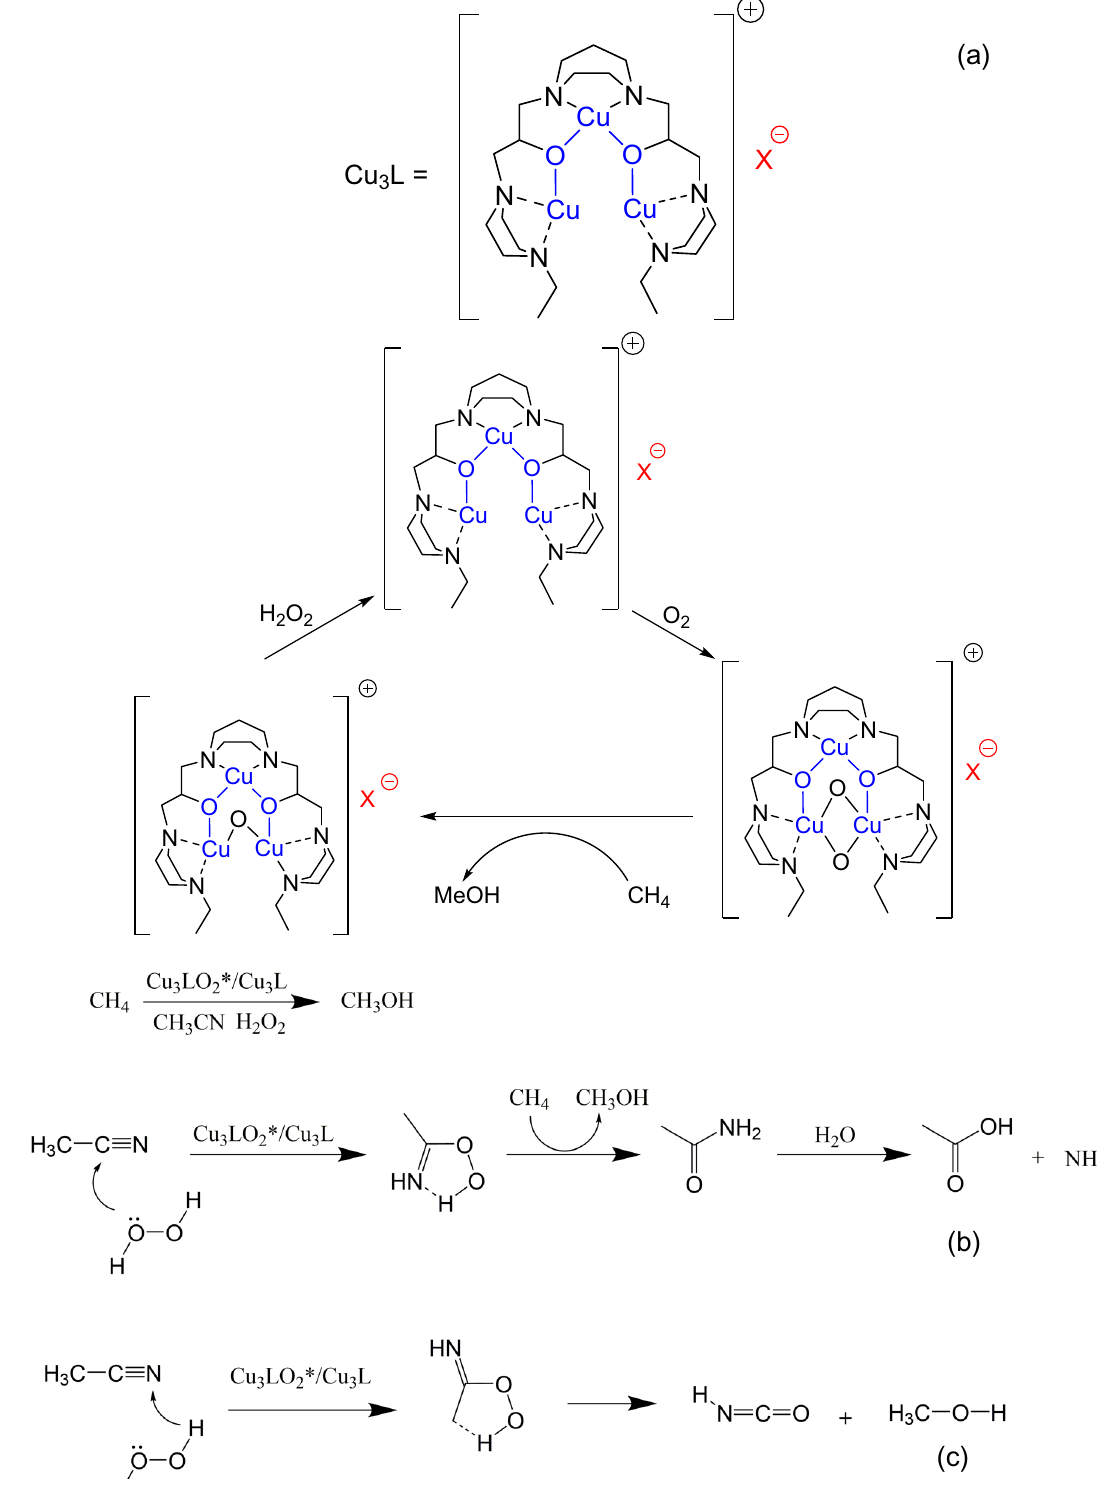
Figure 1. Proposed mechanism of tricopper complex mediated acetonitrile oxidation. ( a ) Shows prior work while ( b ) is this work’s findings on acetonitrile decomposition and ( c ) methanol and formamide (via isocyanurate hydration) production from